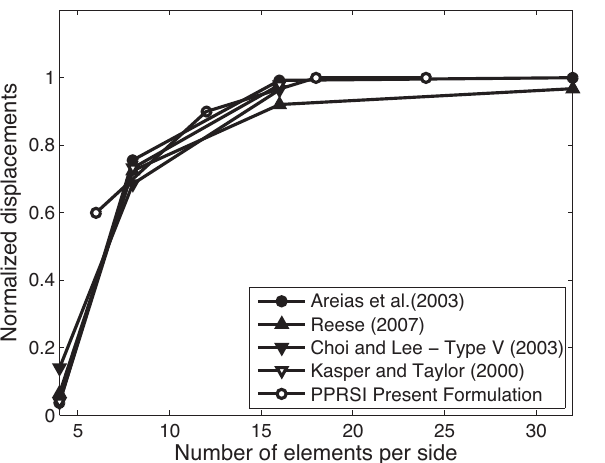
Figure 7: Numerical test example 3 (a dome with opening): conver- gence of the radial normalized displacement ( w ex = 0.0930 mm from [ ? ])